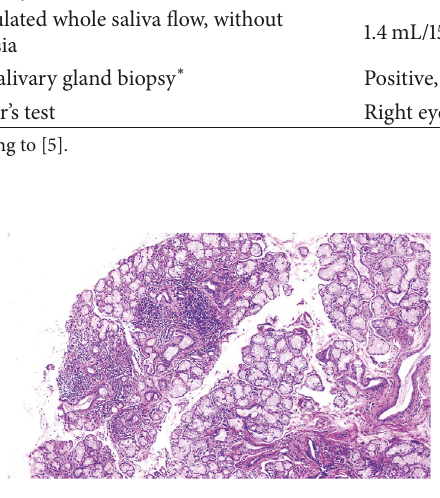
Figure 1: A panoramic photo of minor salivary gland biopsy. A chronic lymphocyte focal sialadenitis was